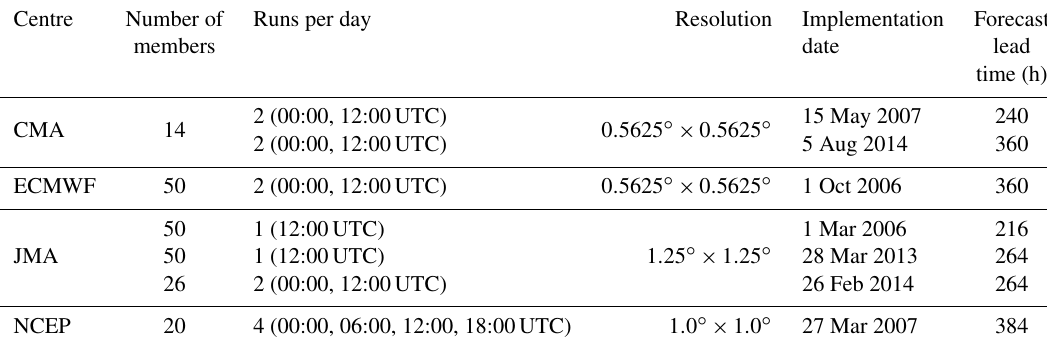
Table 1. Information of selected data sources from TIGGE archive. Centre Number of Runs per day Resolution Implementation Forecast